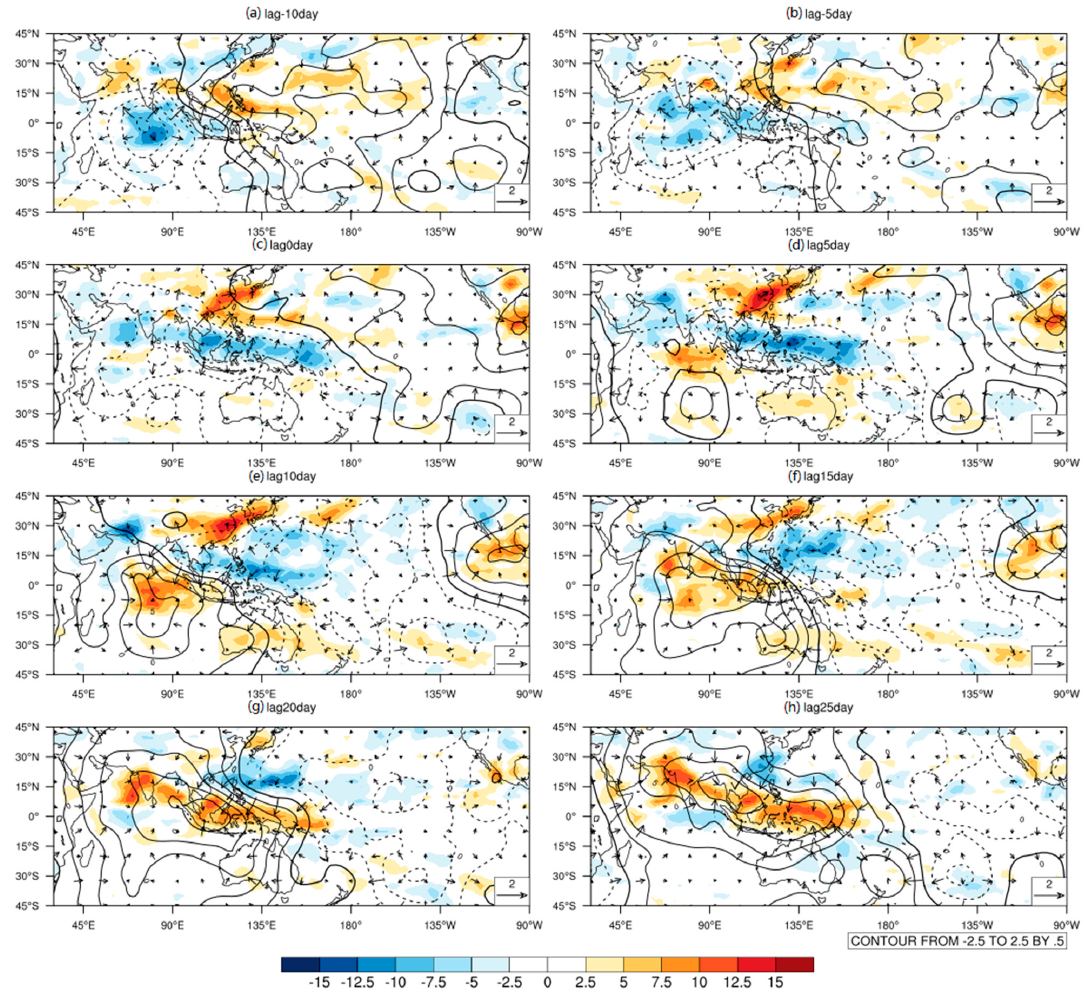
Figure 9. Same as Figure 8, but for 30-to-90-day intra-seasonal variability on lag days of − 10 ( a ), − 5 ( b ), 0 ( c ), 5 ( d ), 10 ( e ), 15 ( f ), 20 ( g ), 25 ( h ) of all EHW